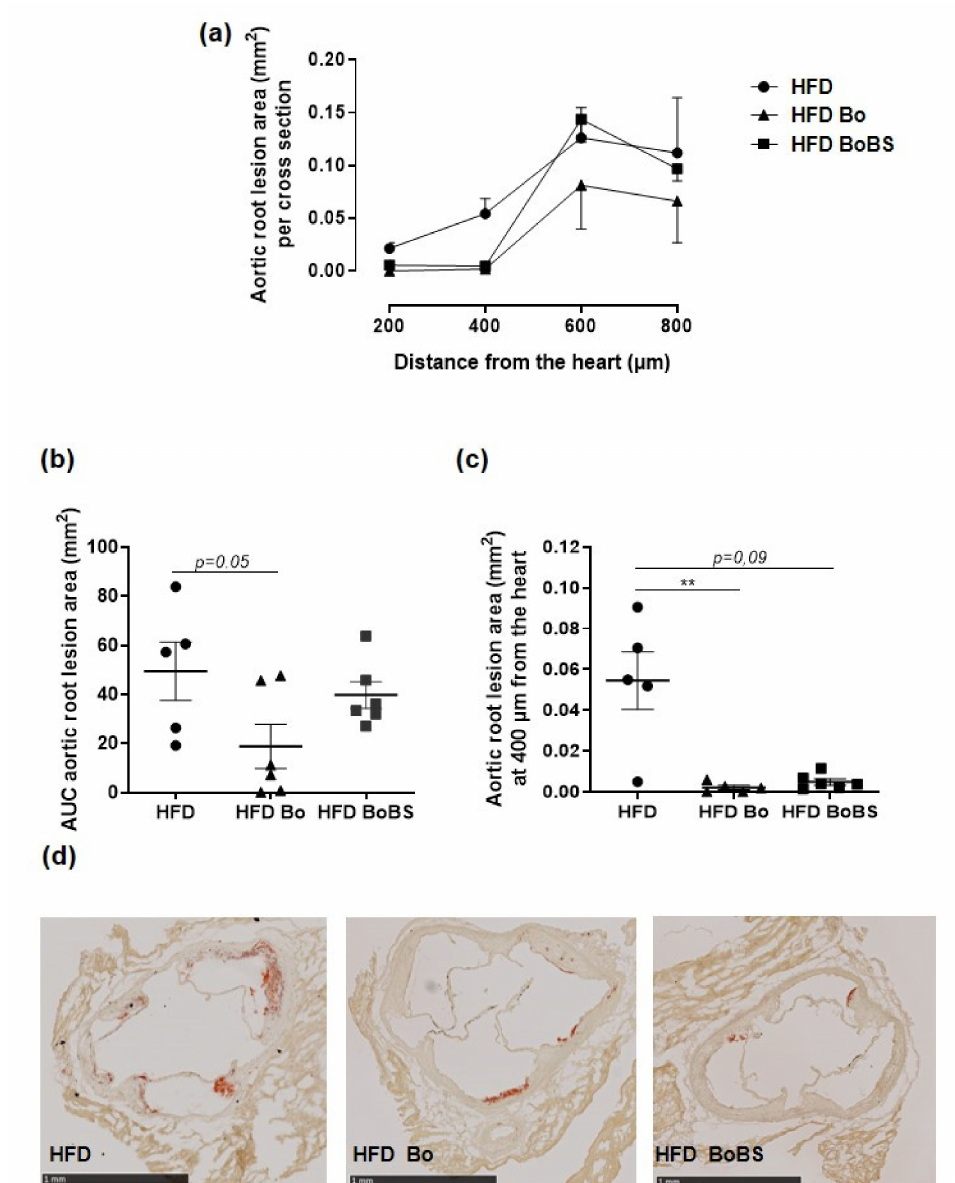
Figure 7. Carrot supplementation reduces atherosclerotic lesions of ApoE − / − mice. Quantification of the aortic root oil red O at all distances from the heart ( a ), and subsequent calculation of AUC ( b ). Specific quantification of lesions at 400 µ m from the heart ( c ), and representative images of three valve leaflets as observed at 400 µ m from the heart (scale bar 1 mm) of stained aorta ( d ) from mice maintained a HFD (black circle, n = 5; samples from 5 males), or HFD containing Bolero under standard condition (Bo, black triangle, n = 6; samples from 6 males), or Bolero under biotic stress condition (BoBS, black square, n = 6; samples from 6 males) throughout the 14 weeks of diet. Data were expressed as mean ± SEM. ** p < 0.01 vs., HFD